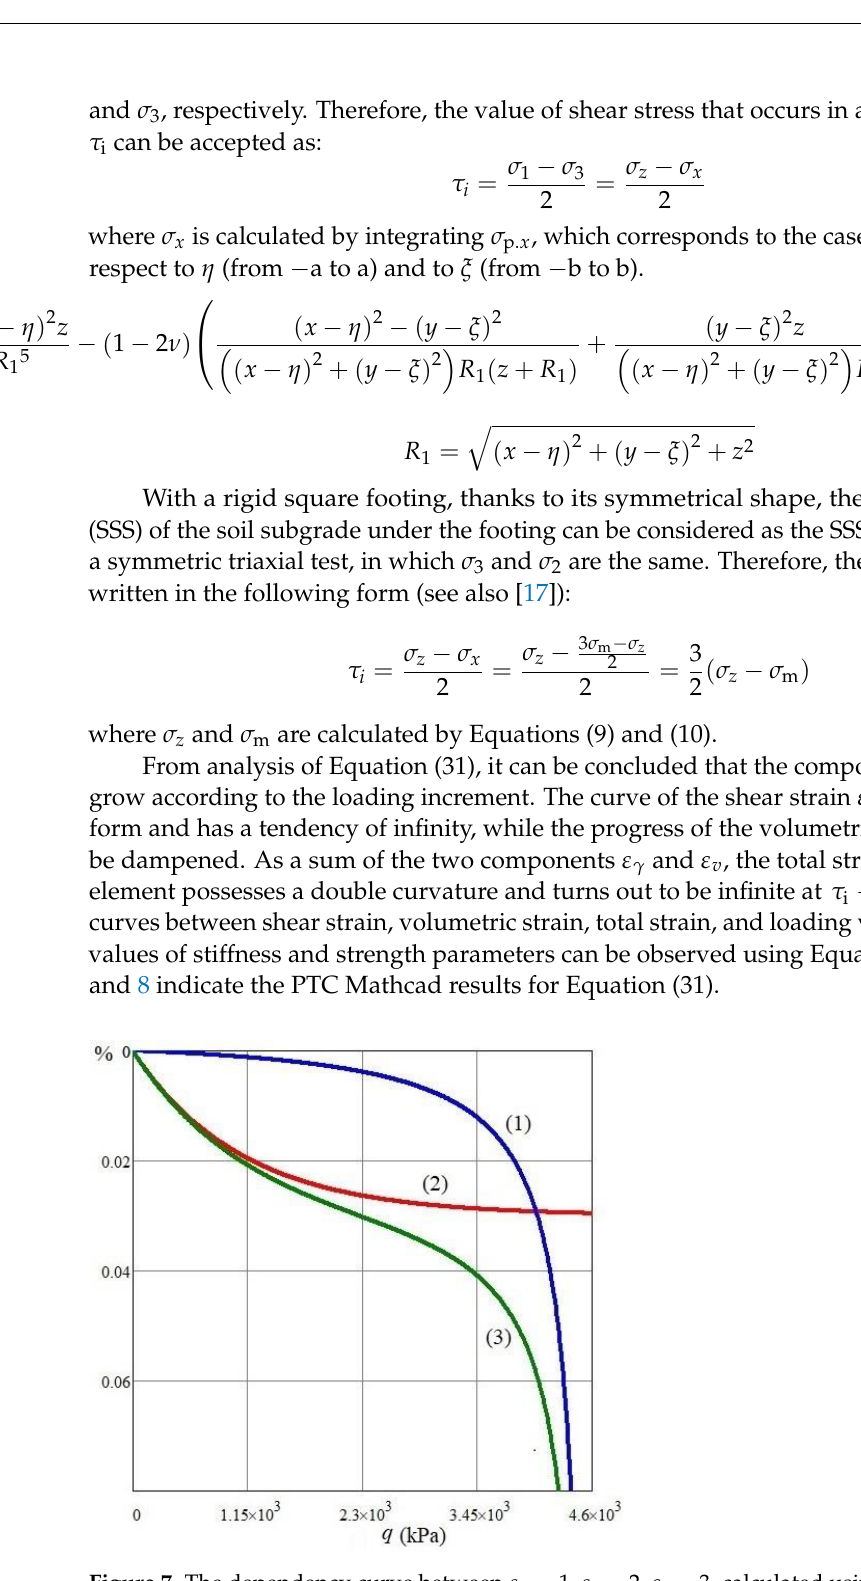
Figure 7. The dependency curve between ε γ − 1, ε v − 2, ε z − 3, calculated using Equation (31) and load q of a soil element at a depth of 5 m.